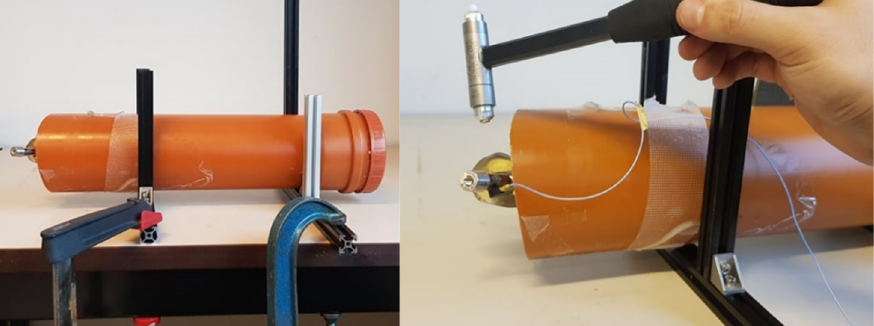
Figure 3. Illustration of setup for the femur–implant structure with artificial soft tissue and measurement procedure, where the excitation hammer and accelerometer are visible.